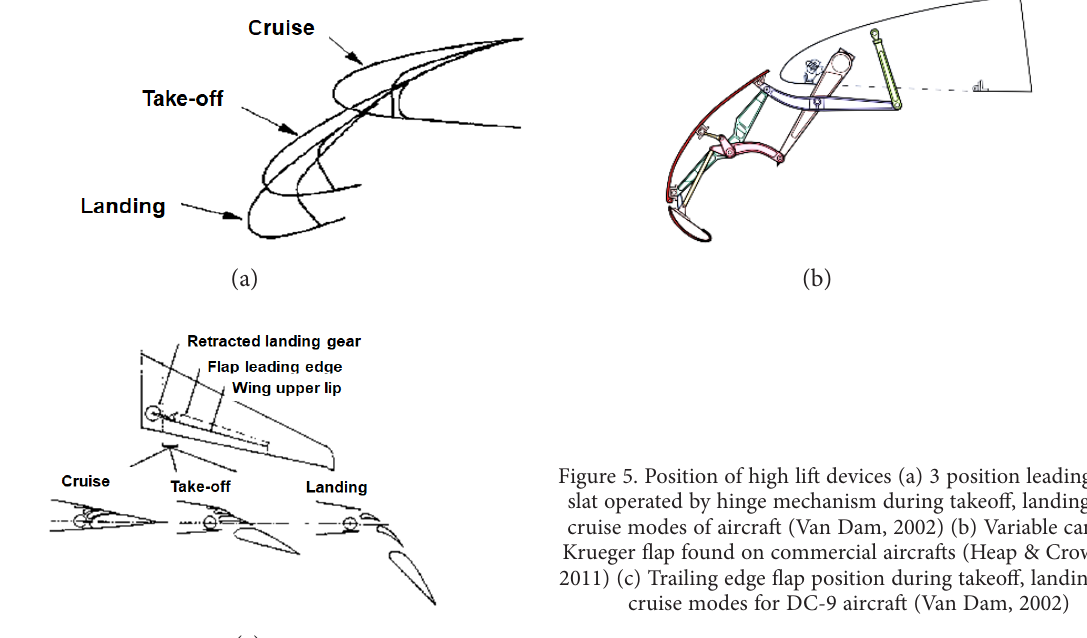
Figure 5. Position of high lift devices (a) 3 position leading edge slat operated by hinge mechanism during takeoff, landing and cruise modes of aircraft (Van Dam, 2002) (b) Variable camber Krueger flap found on commercial aircrafts (Heap & Crowther, 2011) (c) Trailing edge flap position during takeoff, landing and cruise modes for DC-9 aircraft (Van Dam,